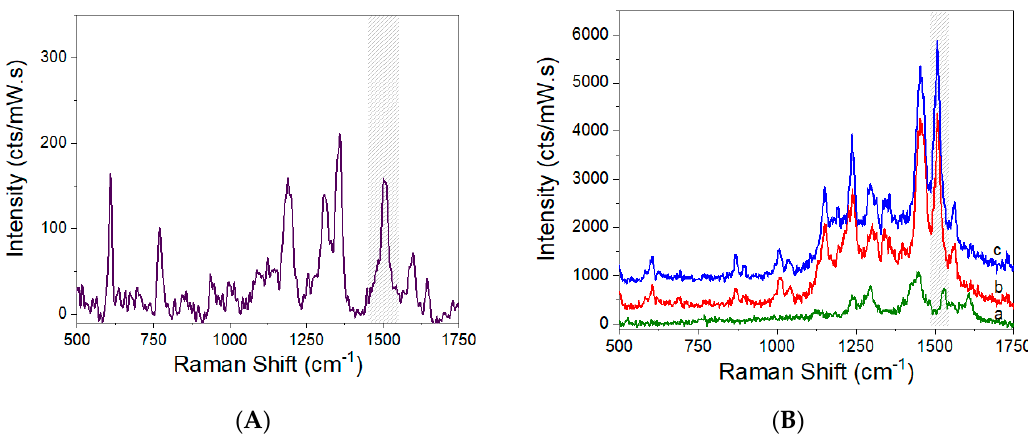
Figure 8. ( A ) Normal Raman spectrum (1000×) of aqueous solution R6G (1 mM). ( B ) SERS spectra of (1 μM) R6G on the SERS substrate: (a) Glass_Ag_AuNPs; (b) 1G_Ag_AuNPs; (c) 3G_ Ag_AuNPs.